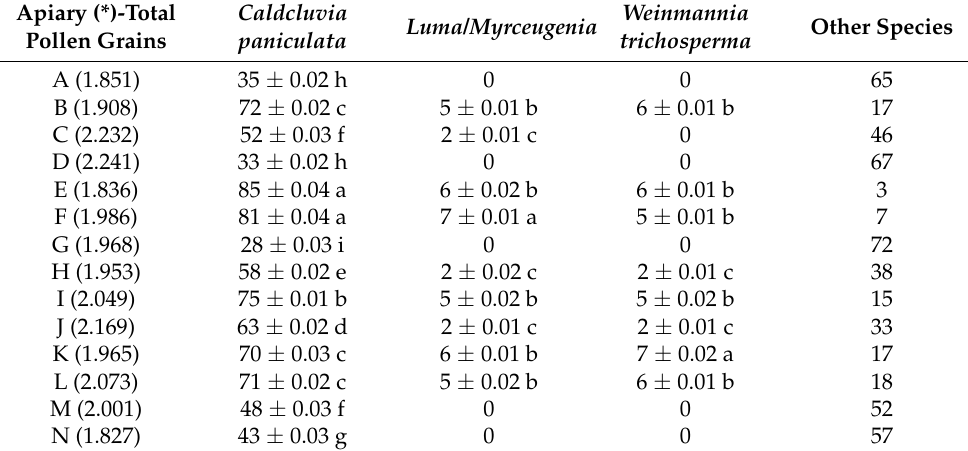
Table 1. Predominant botanical species (%) found in each honey